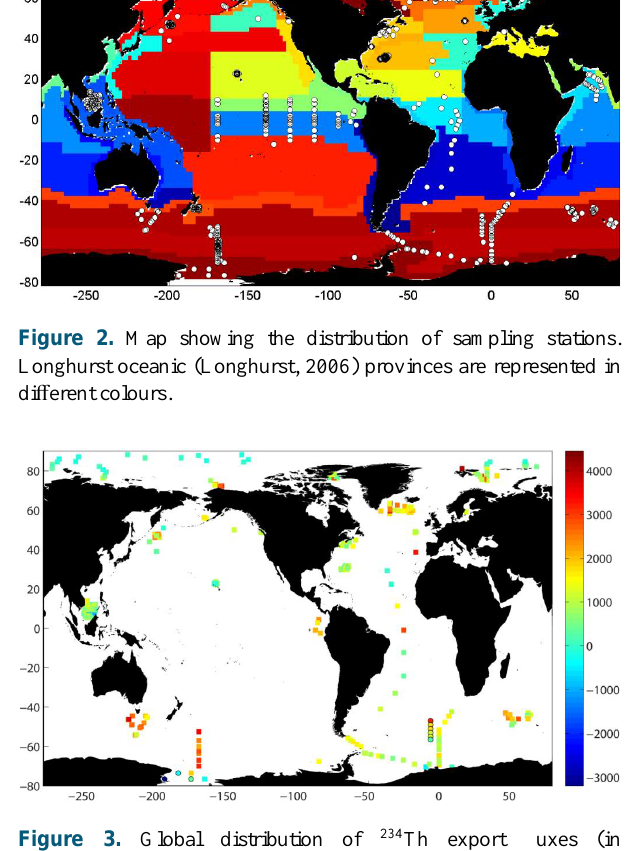
Figure 3. Global distribution of 234 Th export fluxes (in Fig. 3: Global distribution of 234 Th export fluxes (in dpm m -2 d -1 ). SS model (see text) derived 248 dpmm − 2 d − 1 ). SS model (see text) derived fluxes are squares and fluxes are squares and NSS model derived fluxes are circles. 249 NSS model derived fluxes are circles.